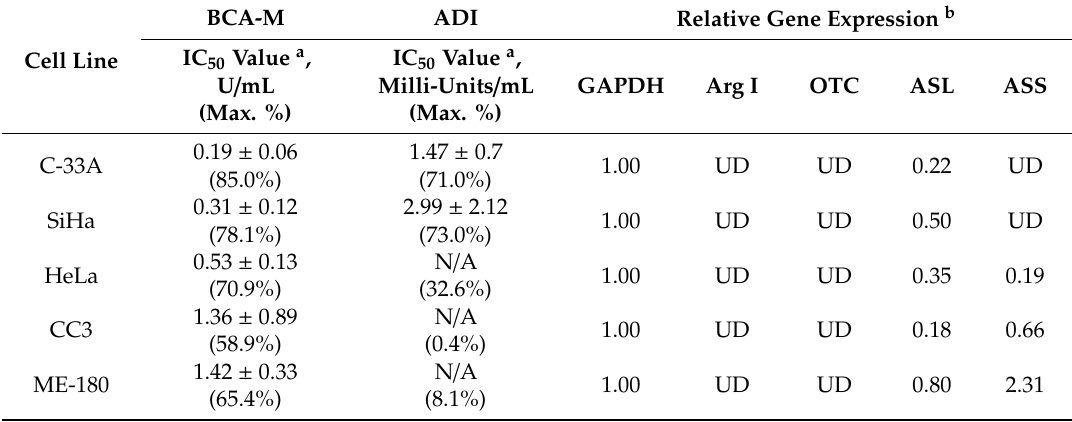
Table 1. IC 50 values, maximum percentage mean suppression and relative gene expression profile of human cervical cancer